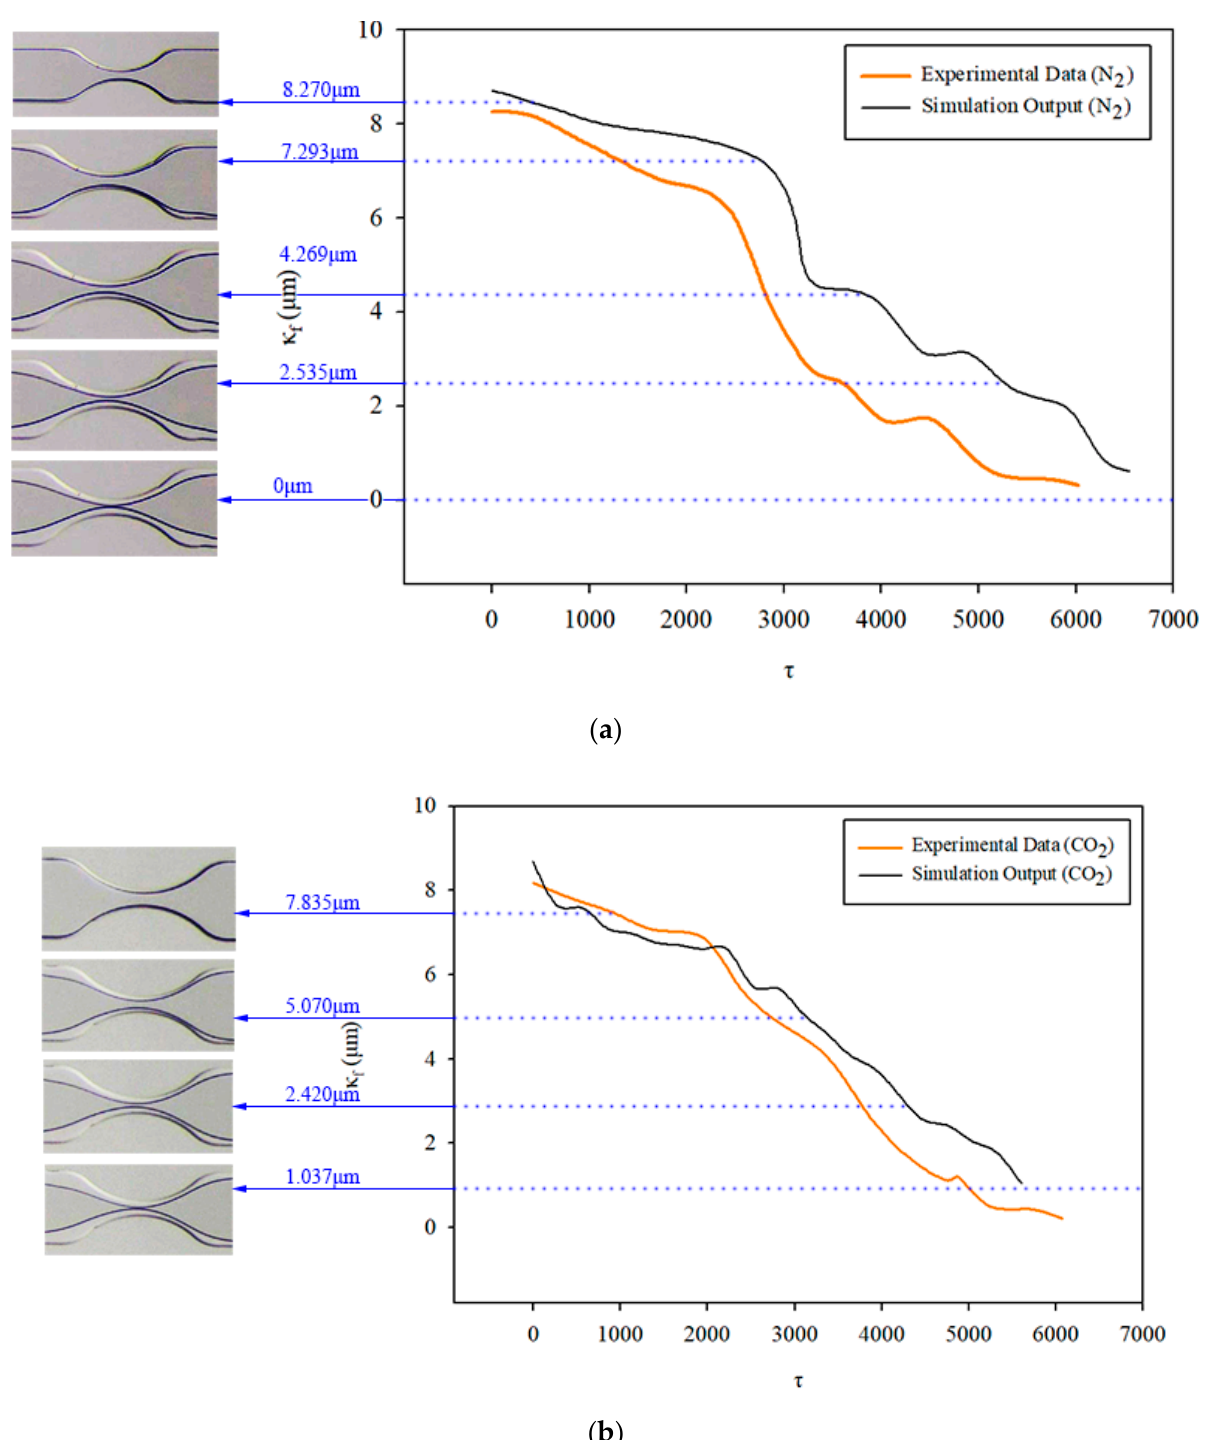
Figure 6. Simulated Interface Radius Comparison for Axisymmetric Pore Throat: ( a ) Nitrogen Gas Group, ( b ) Carbon Dioxide Gas Group.